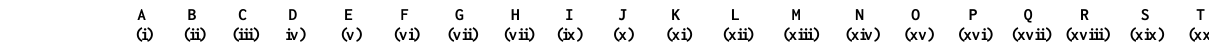
Table 16. Aggregate of Pearson's Correlation Coefficient (r) for Physical characteristics and Neighbourhood Quality